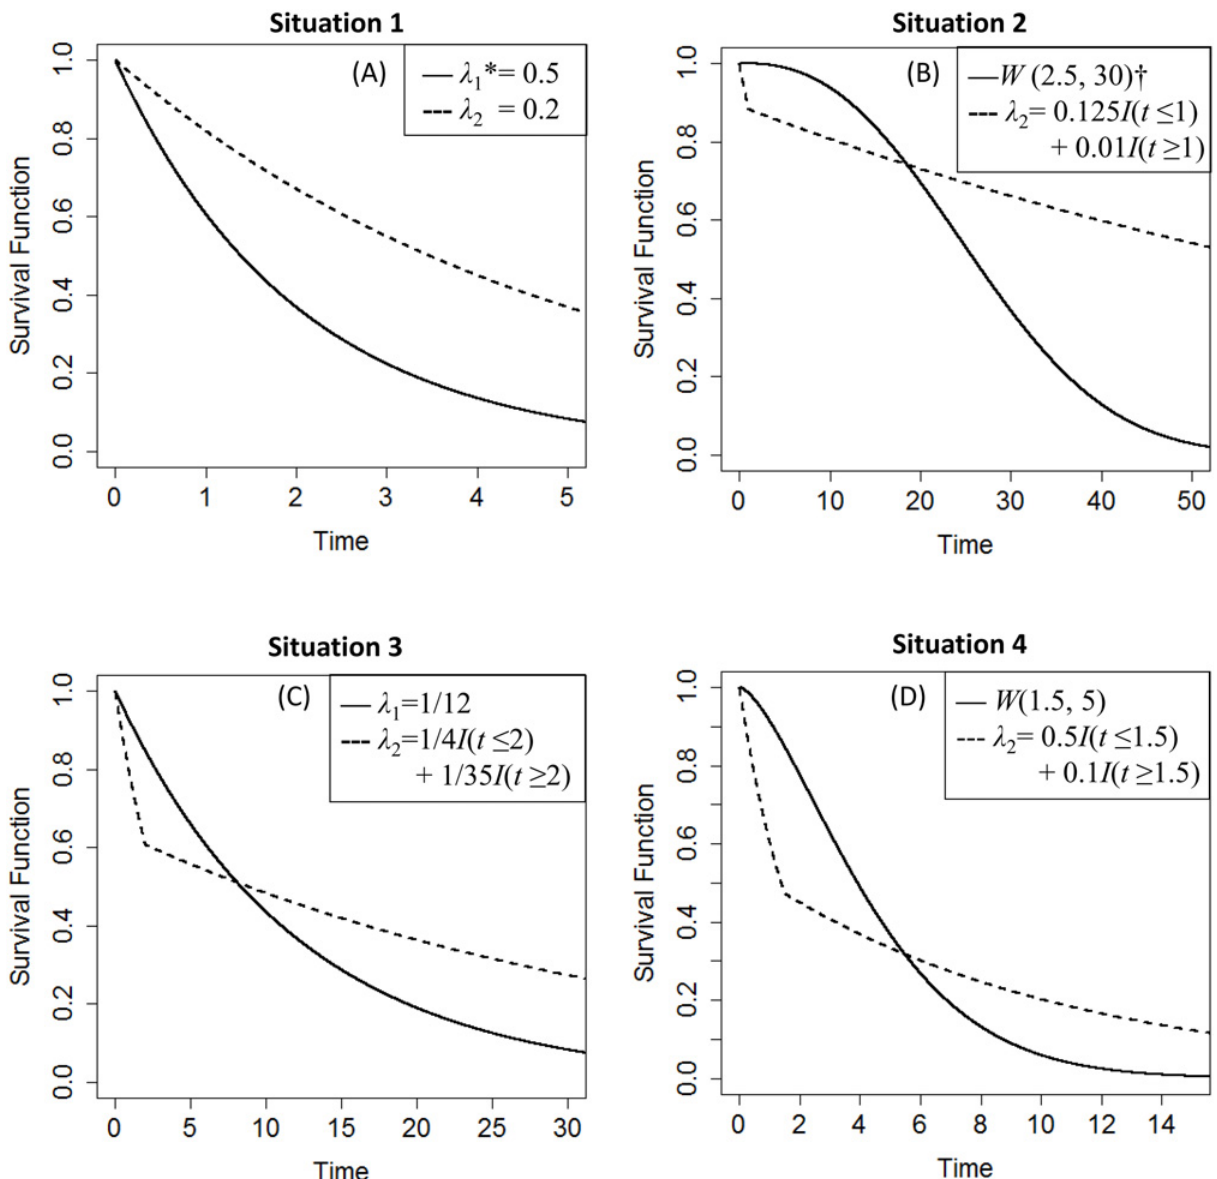
Figure 1. Survival configurations for simulation of power. * λ i denotes the hazard function of S i ( t ), a piecewise exponential distribution. † W( η , θ ) denotes a Weibull distribution having S ( t ) = exp{(- t / θ ) η }, where η > 0 is the shape parameter, θ > 0 is the scale